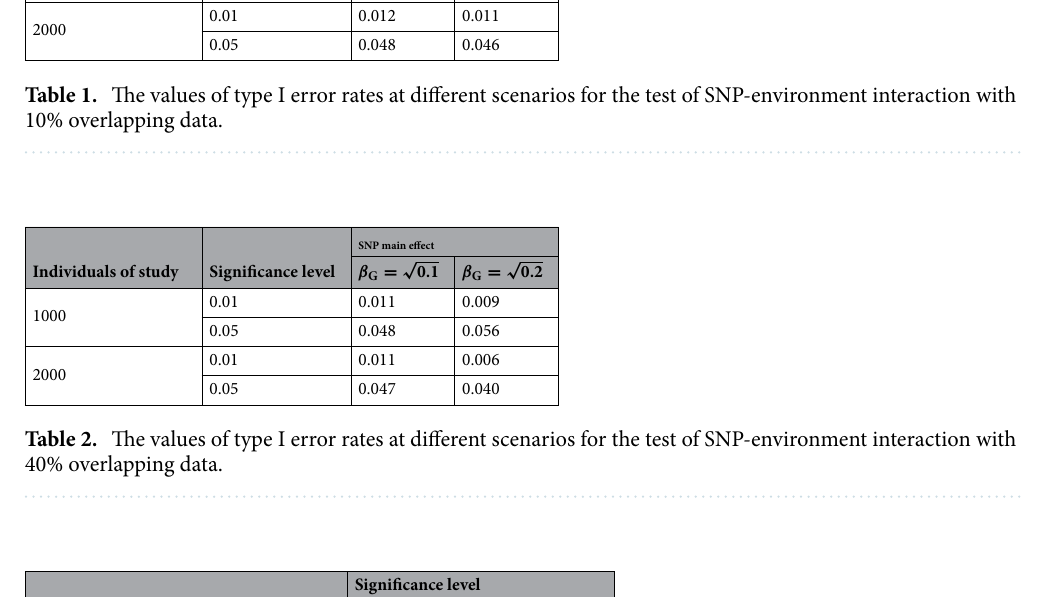
Individuals of study